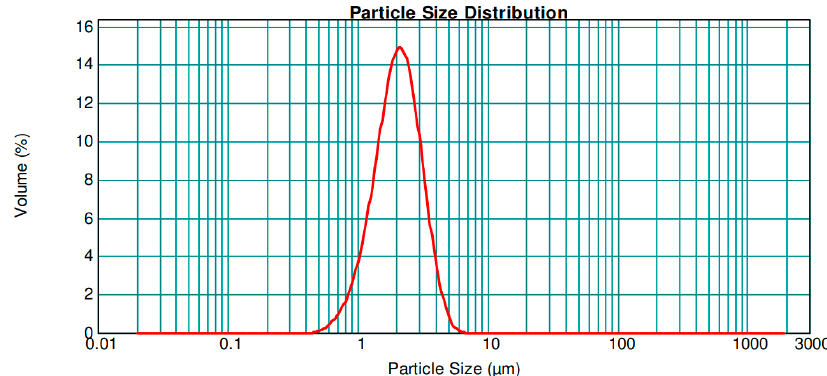
Figure 5. Particle size distribution of the CLA complexes. [CLA stands for CN-NL-GA].